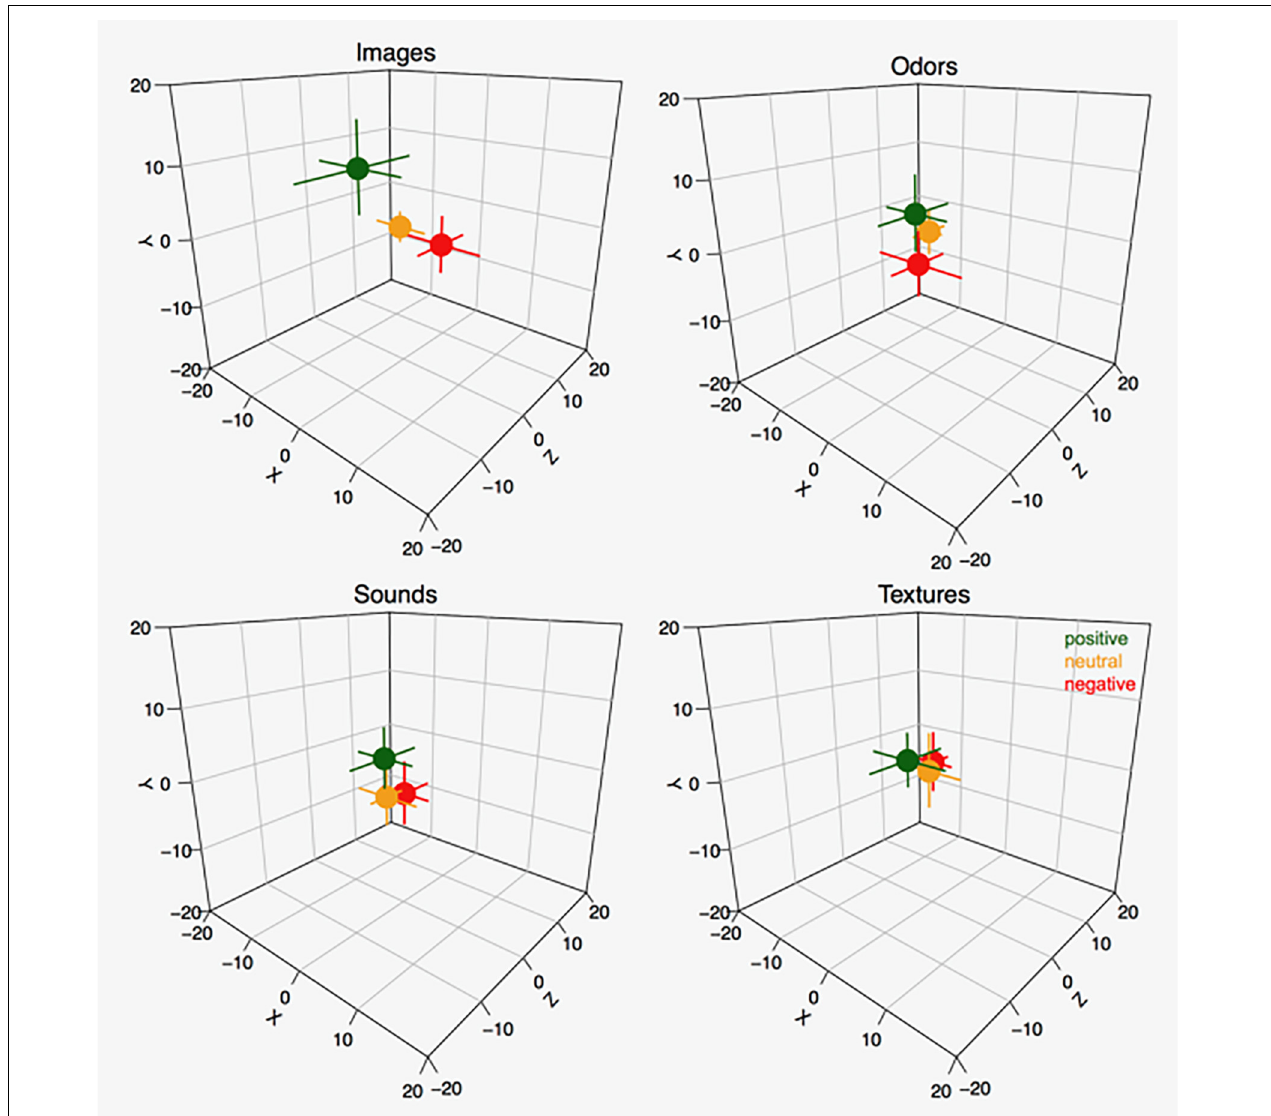
FIGURE 2 | Median X , Y , and Z positions for positive, neutral, and negative stimuli in the four sensory modalities. In order to understand the spatial distribution of the data in relation to the participants’ perspective, assume the participants were facing the cube from the left angle; i.e., in front of the X axis. Error bars represent 95% (cid:16) IQR (cid:17) CIs around the median (estimated as ± 1 . 58 · , where IQR = interquartile range and n = sample √ n